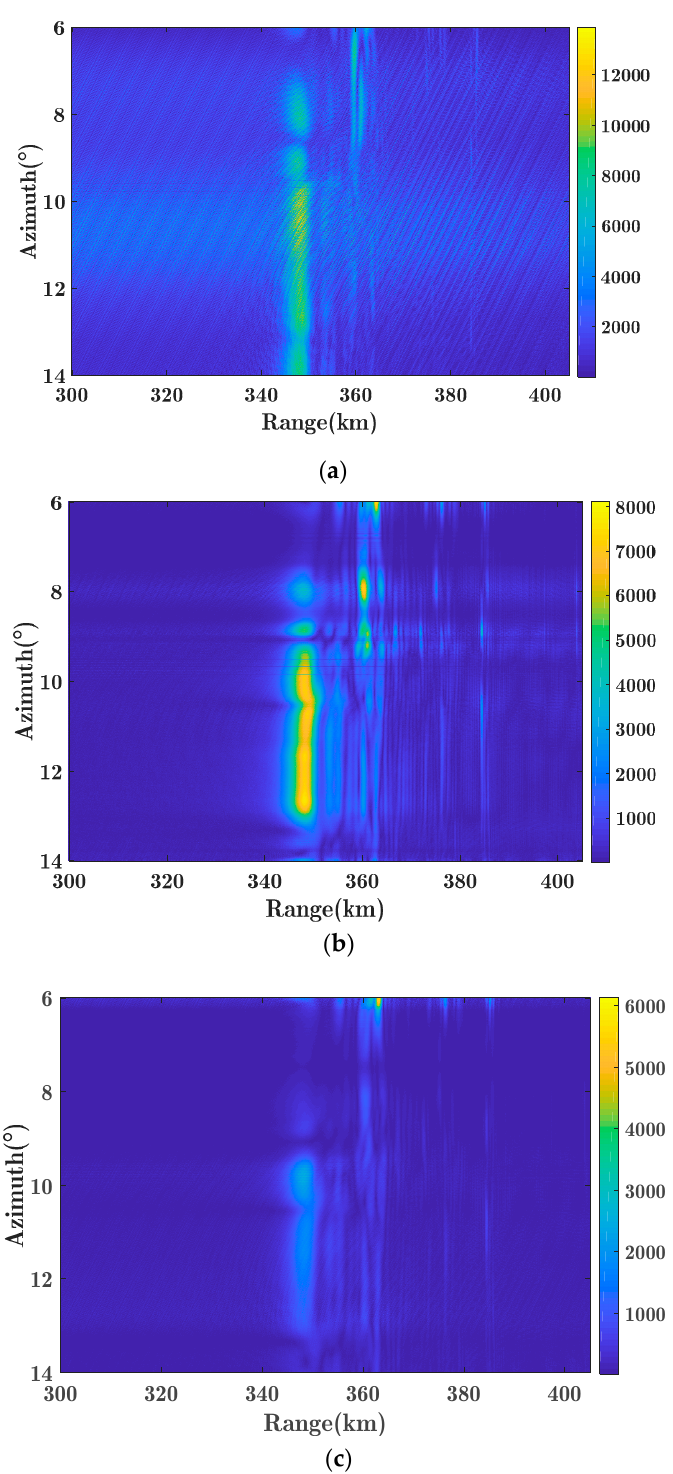
Figure 17. Results of mainlobe jamming suppression: ( a ) raw data; ( b ) proposed method; ( c ) EMP.